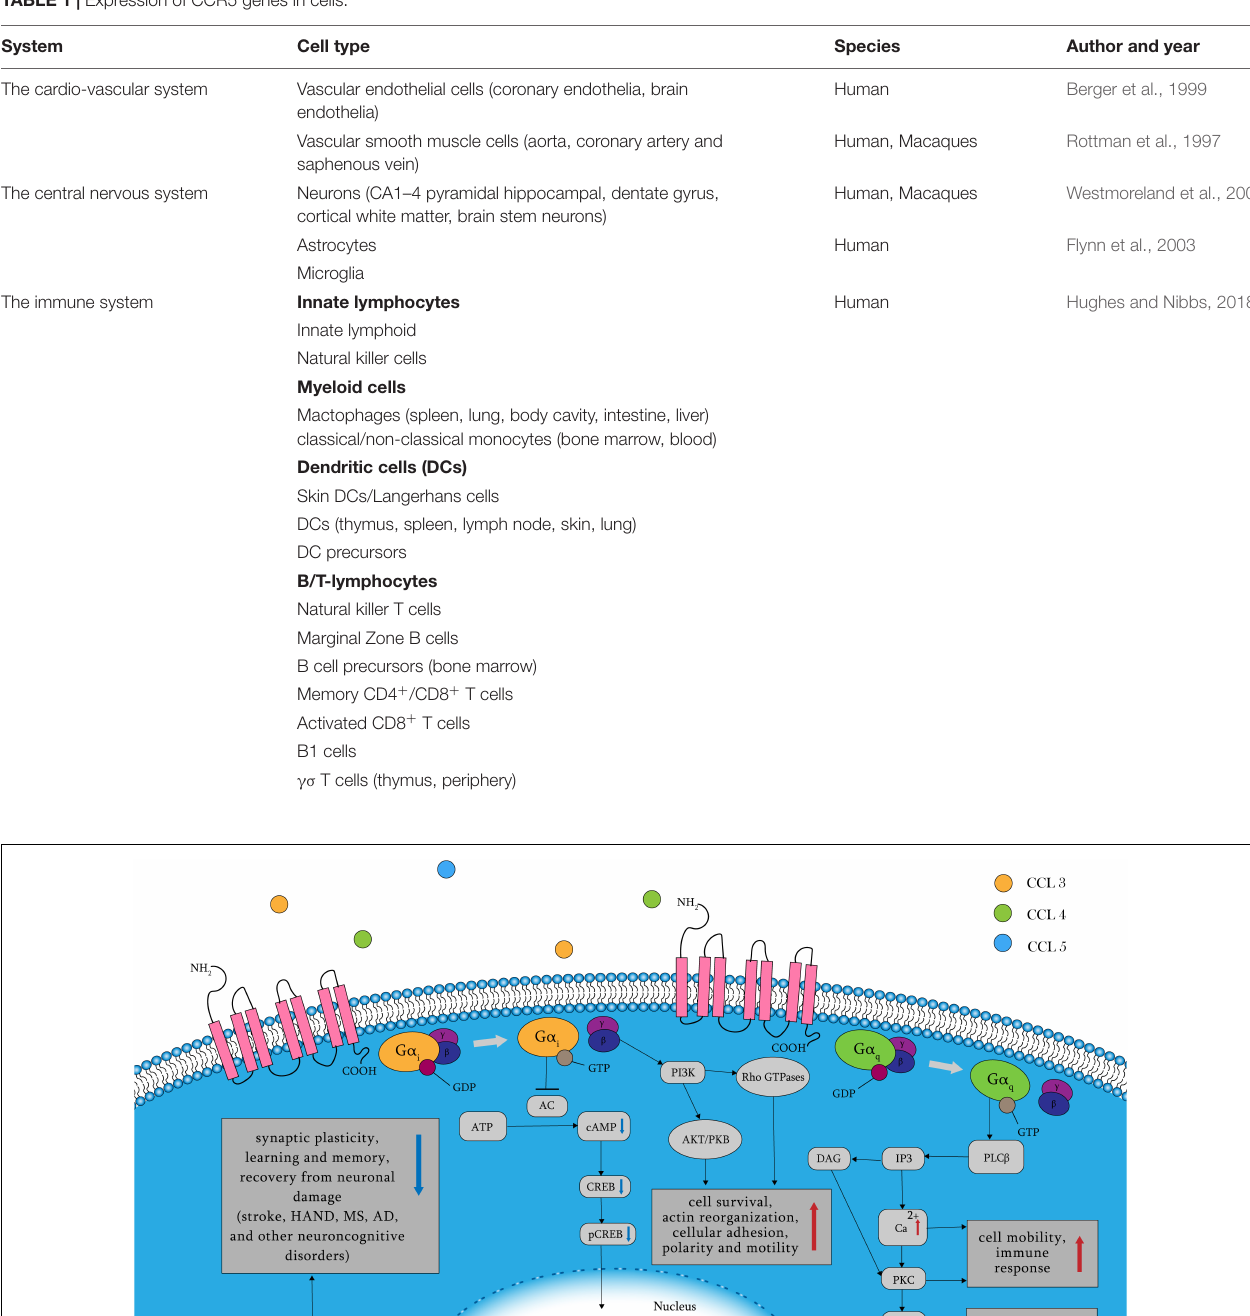
Frontiers in Cellular Neuroscience |